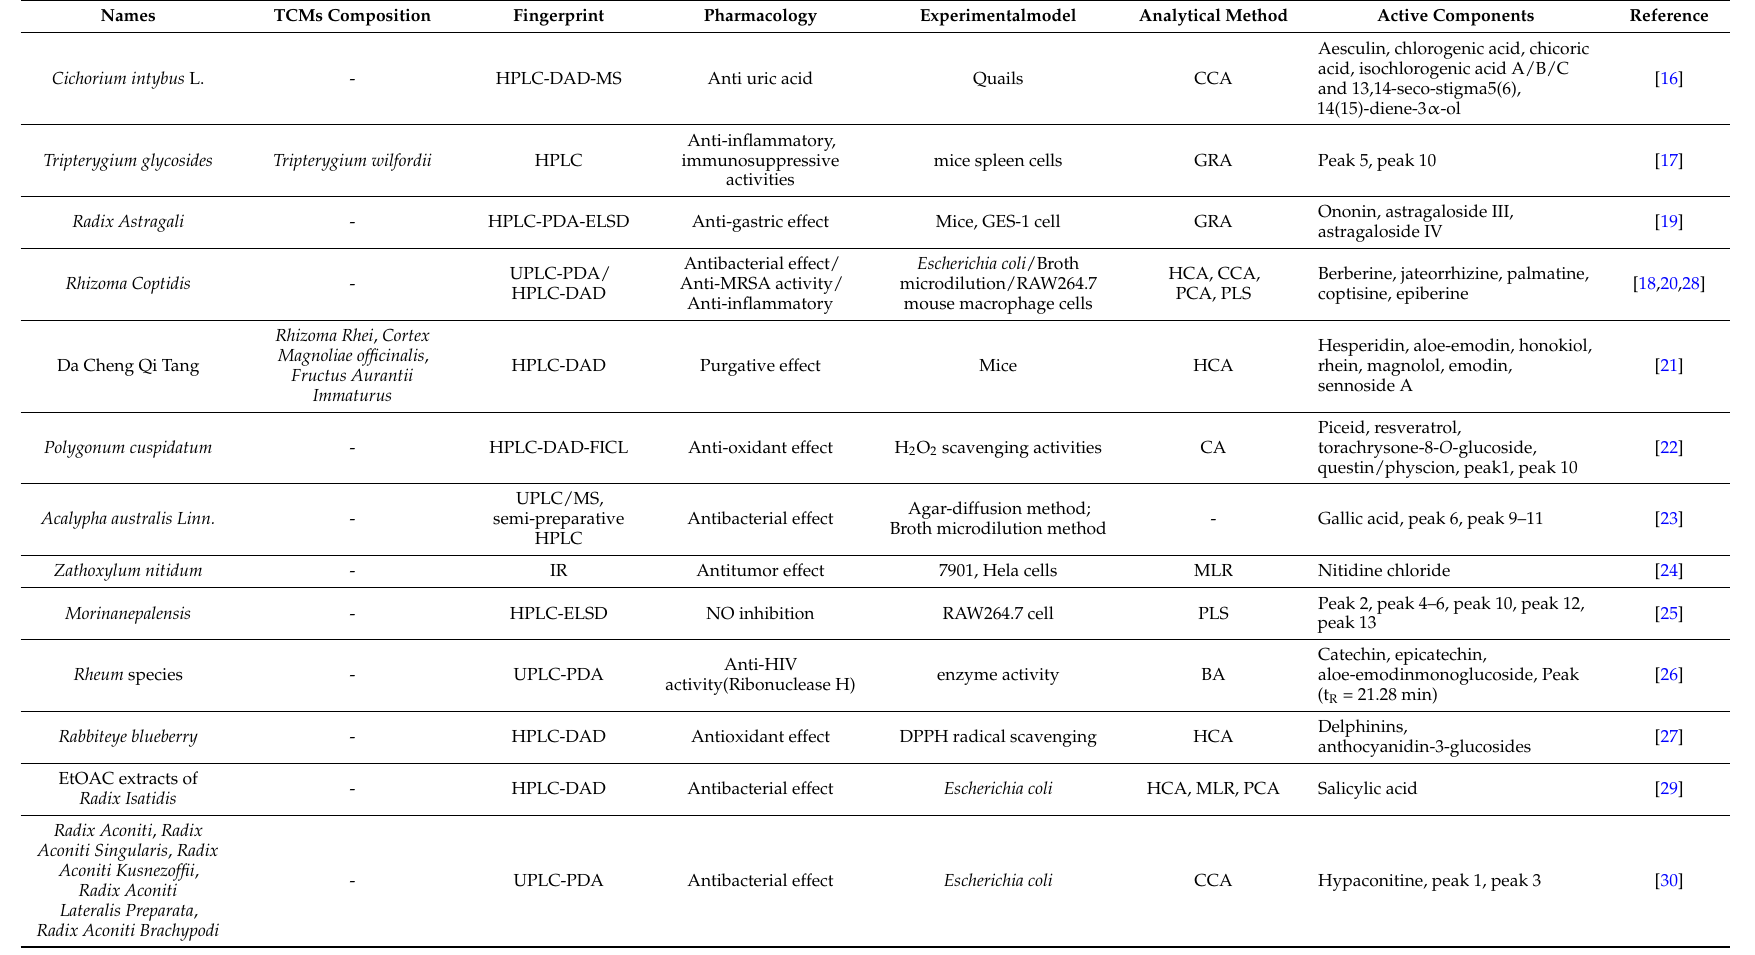
Table 1. Study on the spectrum-effect relationships for Traditional Chinese medicines